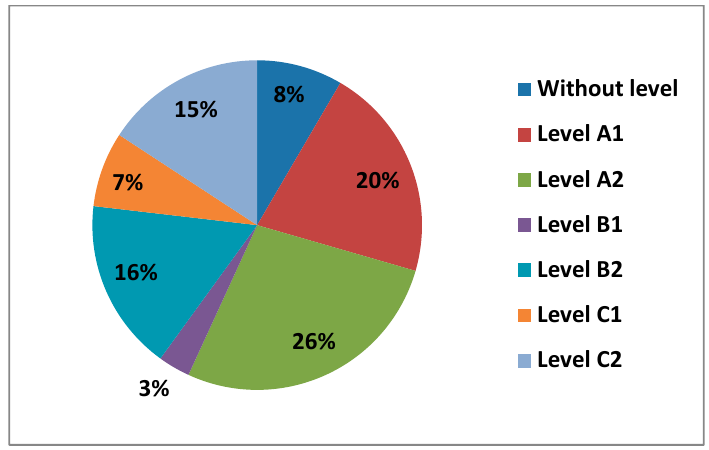
Figure 14. Level of digital competence in teachers in Area 2.